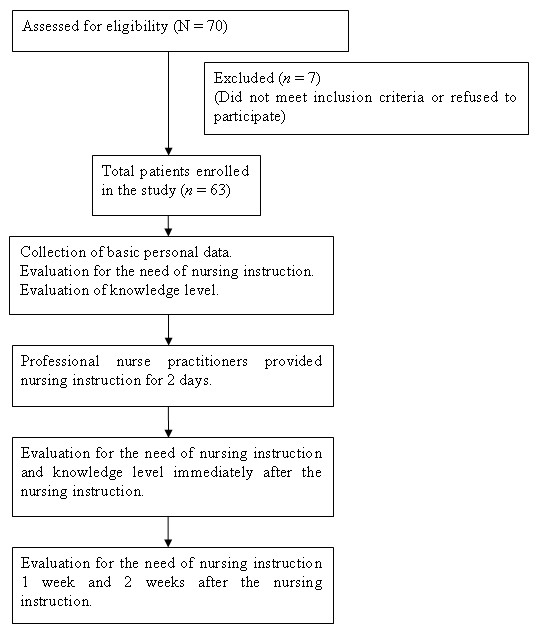
Flow chart of the study design.